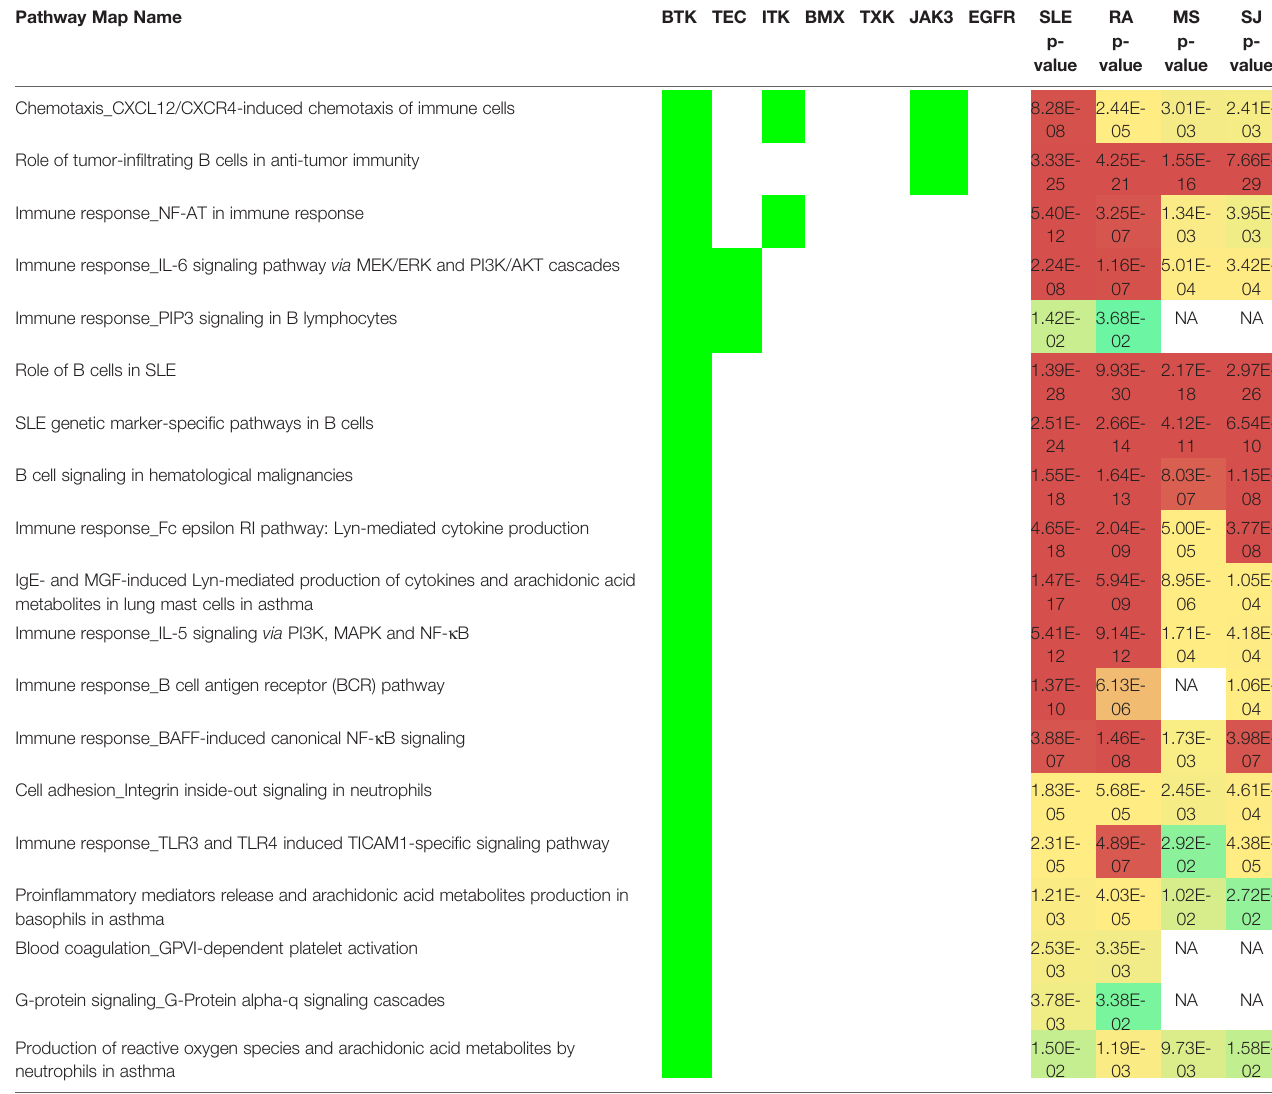
TABLE 3 | Pathway map enrichment with disease biomarkers. Pathway Map